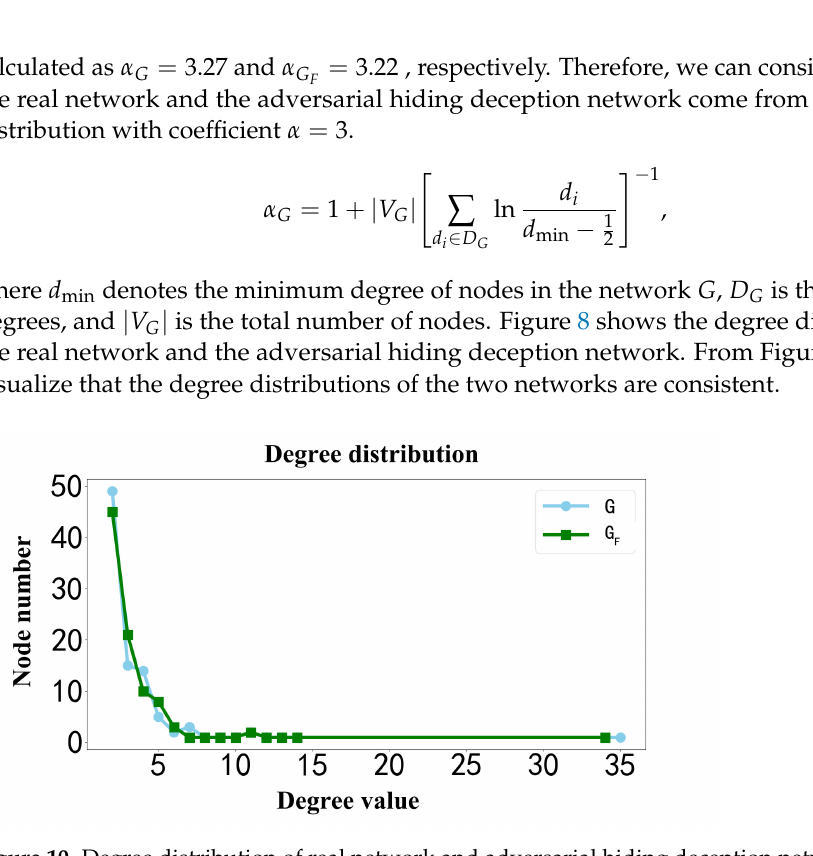
Figure 10. Degree distribution of real network and adversarial hiding deception network.The blue line indicates the degree distribution of the real network G , and the green line indicates the degree distribution of the adversarial hiding deception network G F